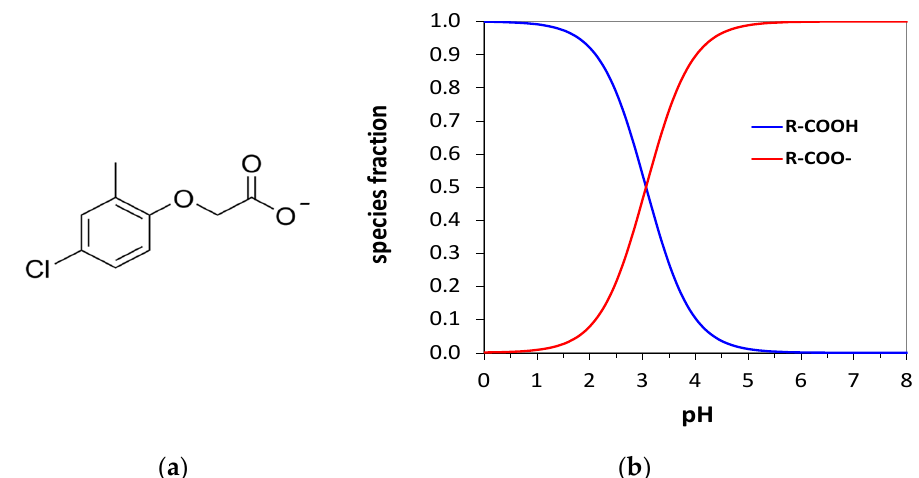
Figure 4. ( a ) Negatively charged deprotonated form of MCPA. ( b ) Graph of species distribution in function of the pH for MCPA.